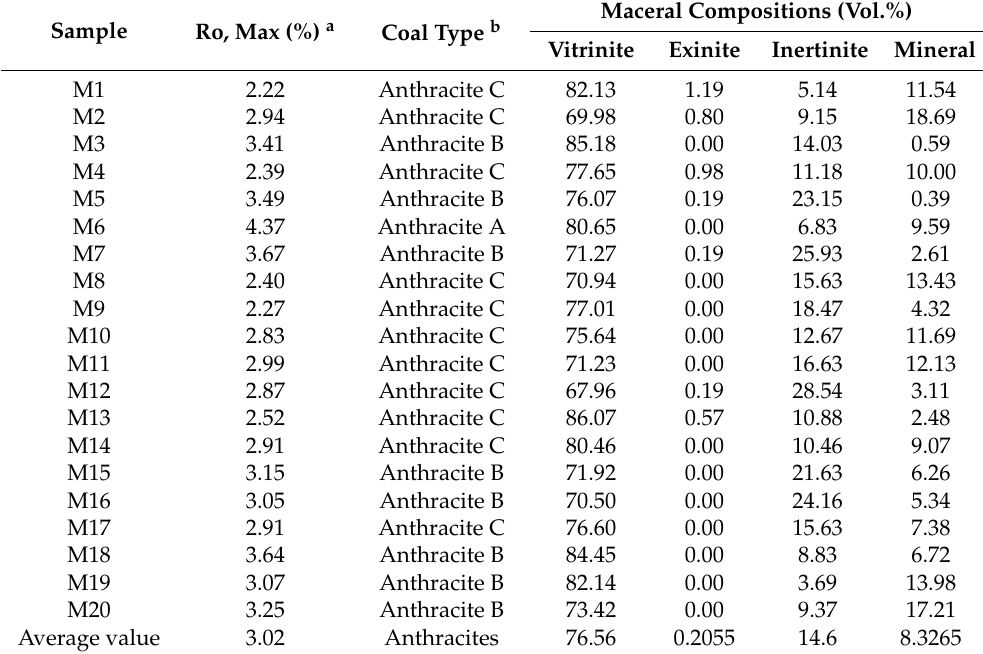
Table 2. Proximate analysis and basic information of high-rank coal